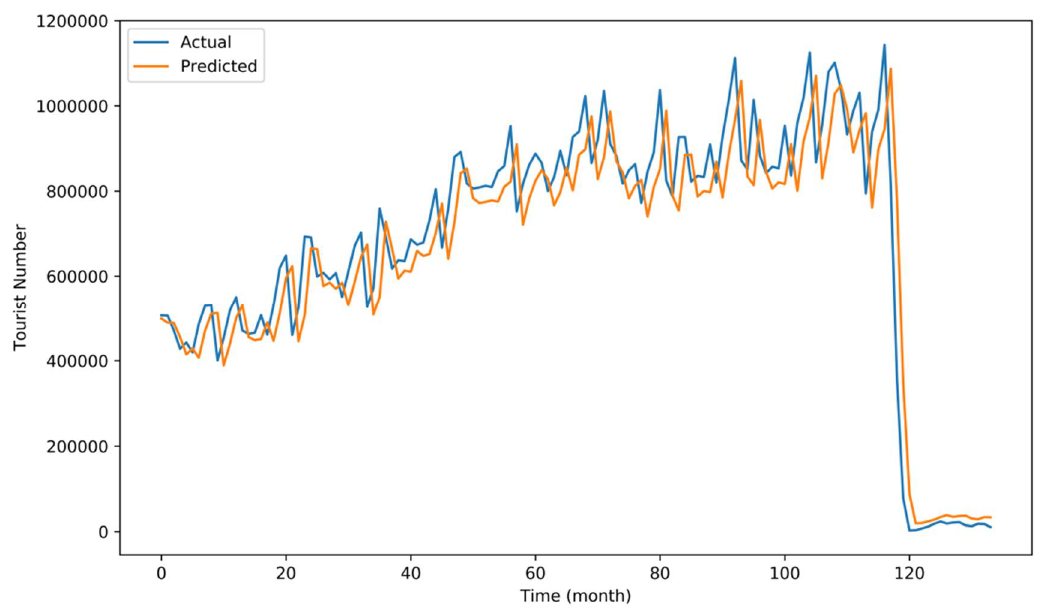
Figure 8. Actual data vs. prediction for Bi-LSTM.